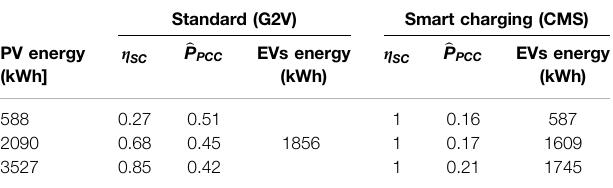
TABLE 2 | Quantitative comparison between standard G2V charging and SC performance under low (588 kWh/d), medium (2090 kWh/d), and high (3,527 kWh/d) irradiance PV